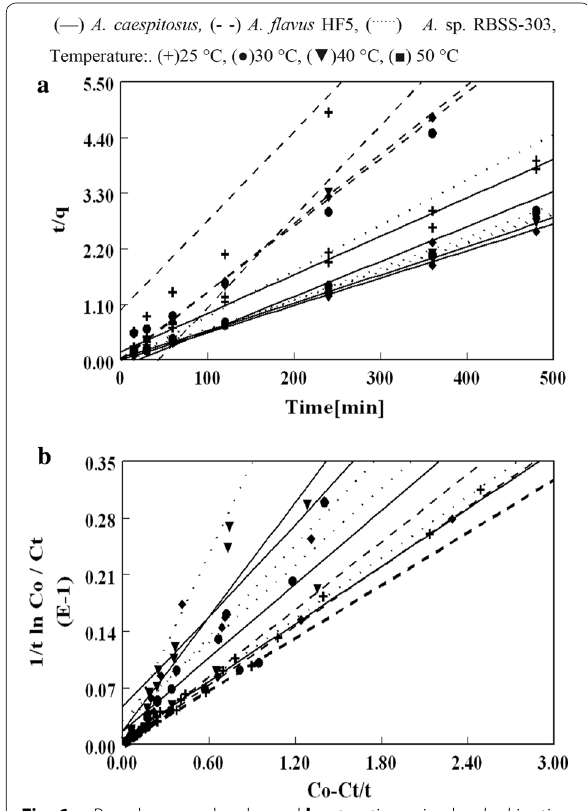
Fig. 6 a Pseudo-second-order and b saturation mixed order kinetic plots of Pb(II) biosorption by A. caespitosus , A. sp. RBSS-303 and A. flavus HF5